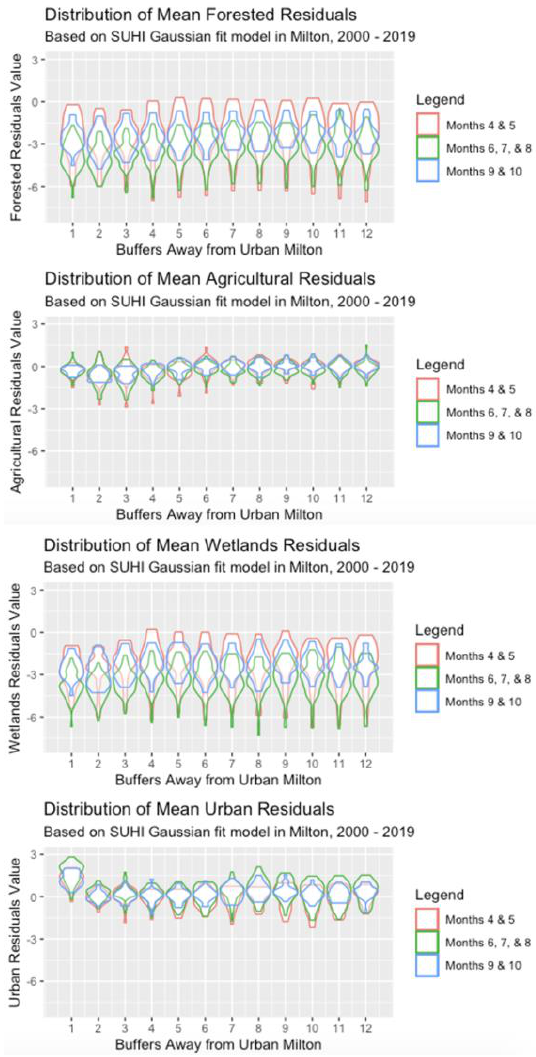
Figure 7 . Density plot of the results from the buffers analysis with the residuals of each land cover within the SUHI models.